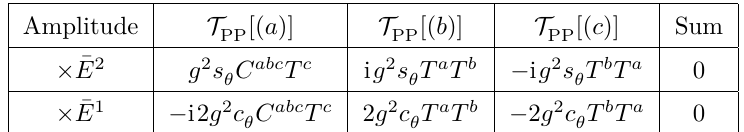
Table 3 . Energy cancellations in the scattering amplitude T [ q T [( c )] of 3d topologically massive QCD, where the relevant Feynman diagrams ( a ) - ( c ) are shown PP in figure